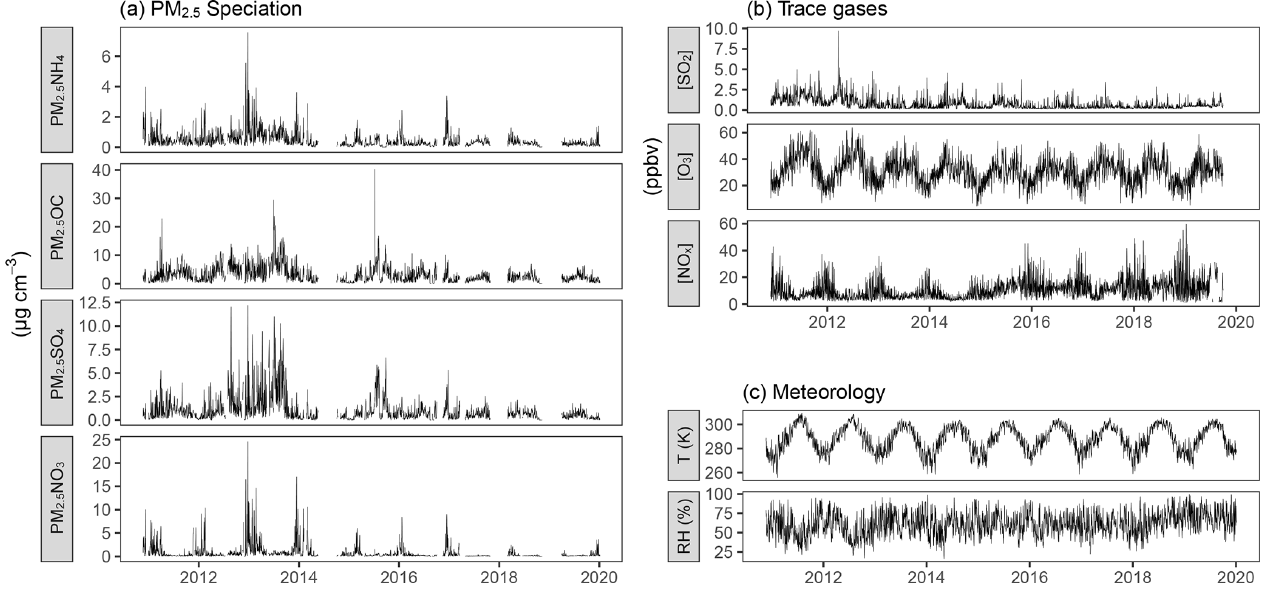
Figure 11. Time series (daily-aggregated) for predictors at the ARM SGP site: (a) PM 2 . 5 speciation; (b) trace gas; and (c) meteorological